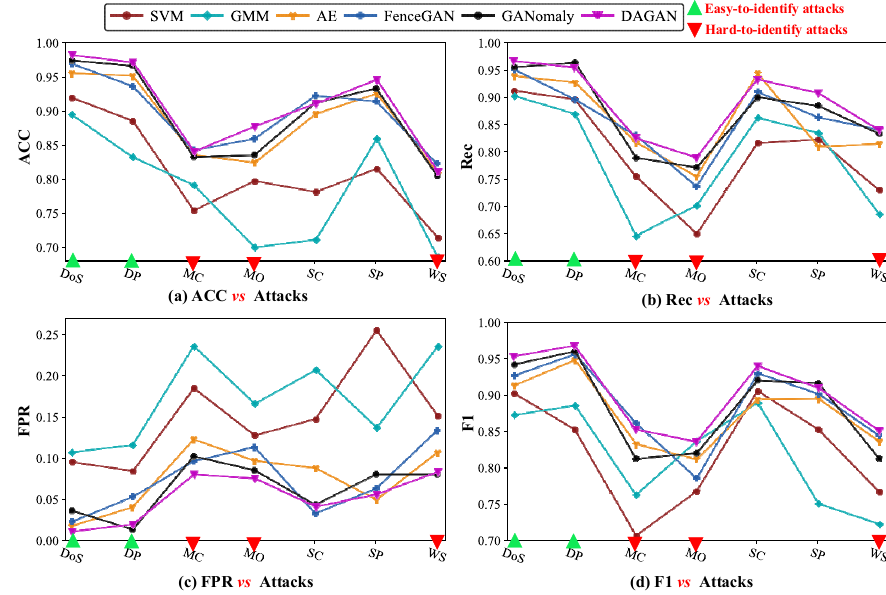
Figure 9. Anomaly detection performance analysis of multiple models on DS2OS dataset.